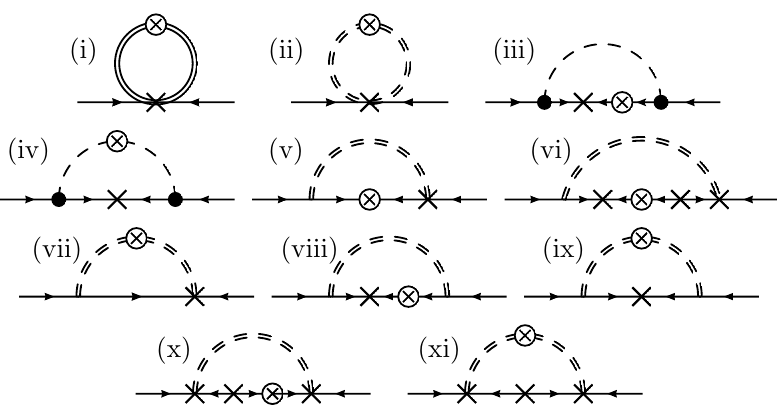
Figure 6 . Diagrams contributing to the left-handed Majorana mass in the Landau gauge ( (cid:11) ! 0) with (cid:12) = 0. The single-solid and broken lines exhibit fermion and scalar-boson ( (cid:30) ), respectively, while the double-solid and broken lines are spin 2 ( h TT ) and spin 0 ( h = (cid:22) g (cid:22)(cid:23) h (cid:22)(cid:23) ) gravitons, (cid:22)(cid:23) respectively. The cross in circle denotes the cuto(cid:11) insertion into the propagators, i.e. (cid:10) = @ t R k . The cross and black-point stand for the Majorana masses and the Yukawa coupling,